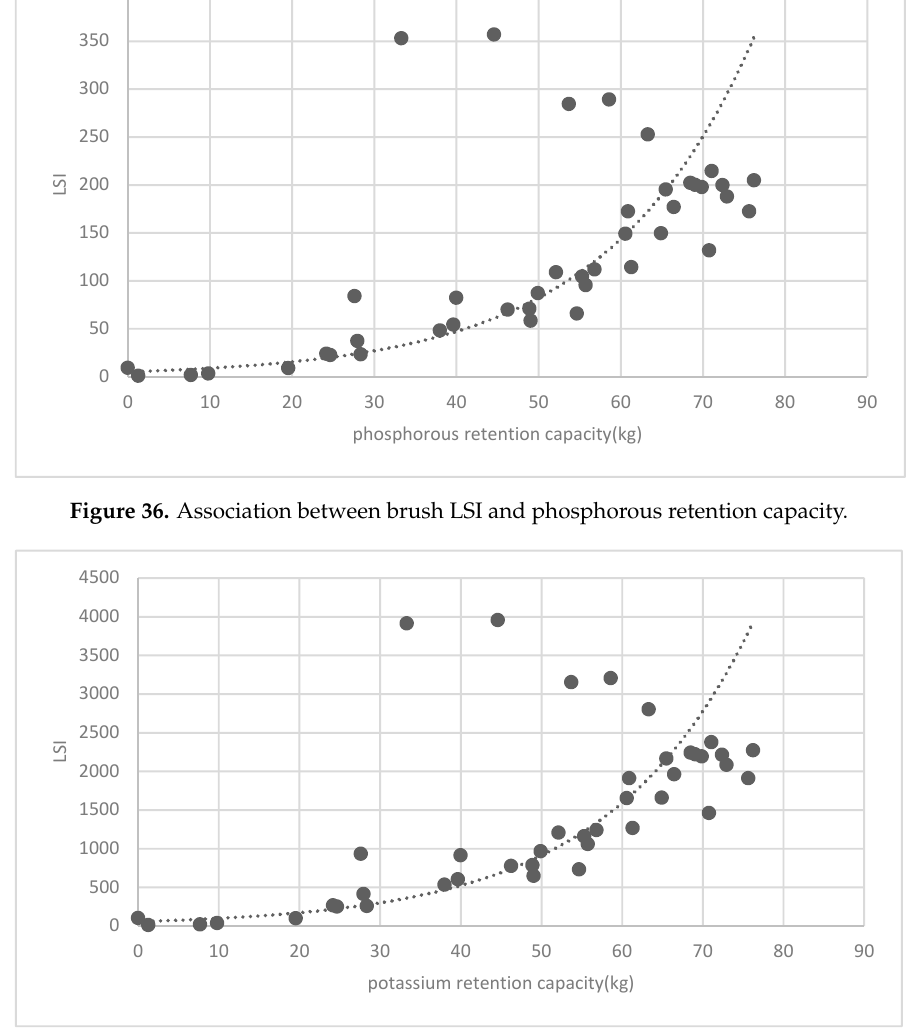
Figure 37. Association between brush LSI and potassium retention capacity.